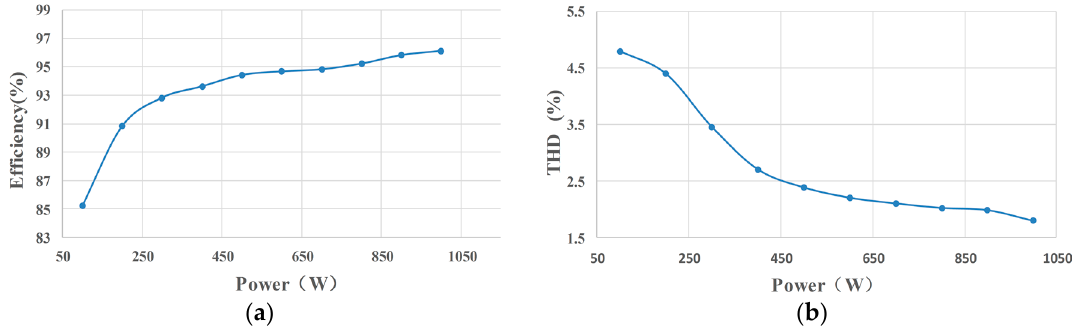
Figure 19. Efficiency and grid current THD curves: ( a ) efficiency under different power level; and ( b ) THD under different power level.